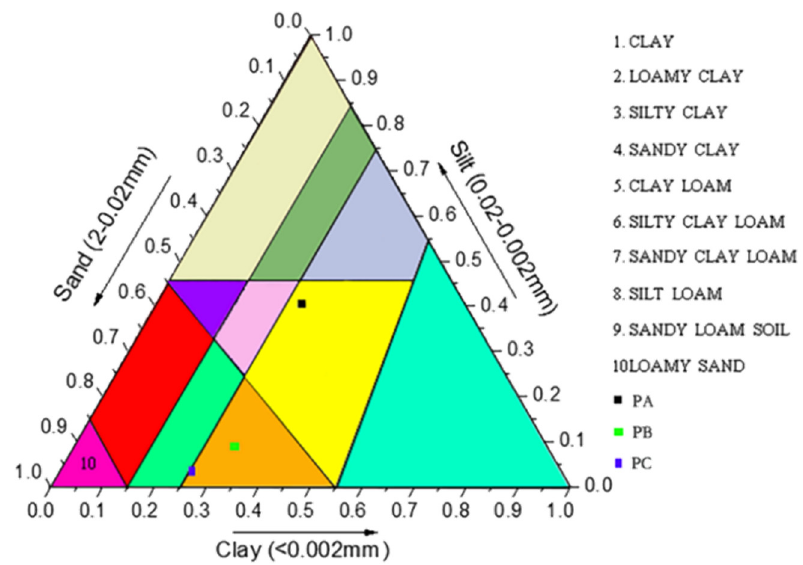
Figure 4. International triangulation of soil texture. PA, soil samples from plot A; PB, soil samples from plot B; PC, soil samples from plot C.